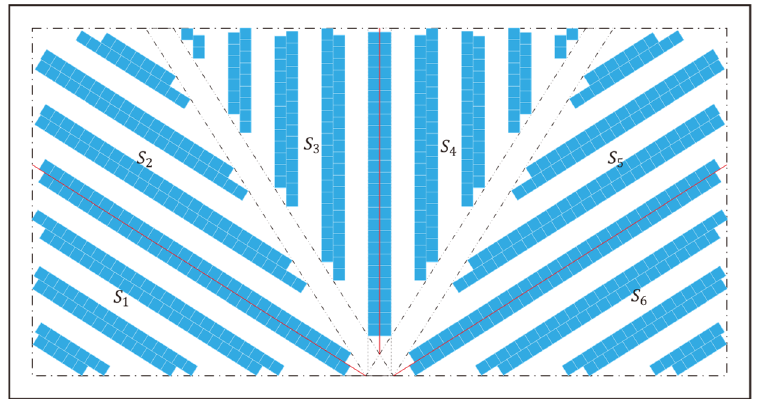
Figure 1. The leaf warehouse layout design.